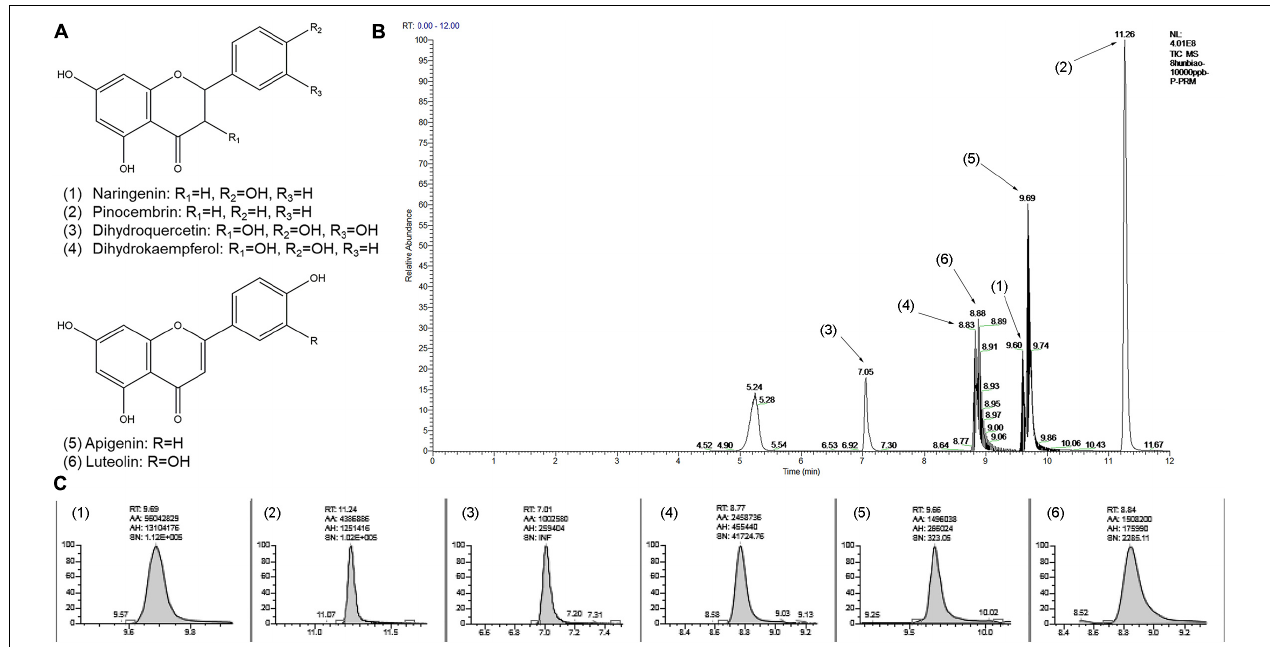
FIGURE 5 | Quantification of several flavonoid metabolites by using high-performance liquid chromatography (HPLC). (A) Chemical structure of the flavonoid metabolites: (1) Naringenin, (2) Pinocembrin, (3) Dihydroquercetin, (4) Dihydrokaempferol, (5) Apigenin, (6) Luteolin. (B) The chromatogram of the mixed standards by HPLC. (C) The chromatogram of the flavonoid metabolites of Chinese fir samples by using HPLC.